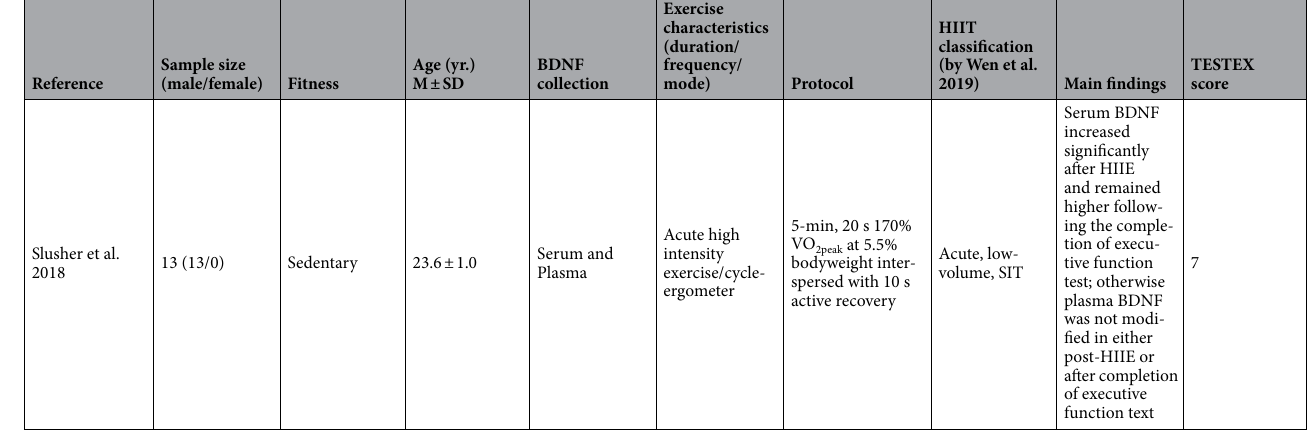
Table 1. Studies included in the meta-analysis. Note: AMRAP: As many repetitions as possible, BDNF: Brain- Derived Neurotrophic Factor. CON: Control group, HIIE: High Intensity Intermittent Exercise, HIIT: High Intensity Interval Training, MAP: Maximal aerobic power, P max : Maximal power, SIT: Sprint Interval Training, ST-HIIT: Short-term High Intensity Interval Training, s VO 2max : Maximal speed reached during VO 2max , VO 2max : Maximal oxygen consumption, VO 2peak : Peak oxygen consumption, W max : Maximal Wattage, WOD: Workout of day, W peak : Peak